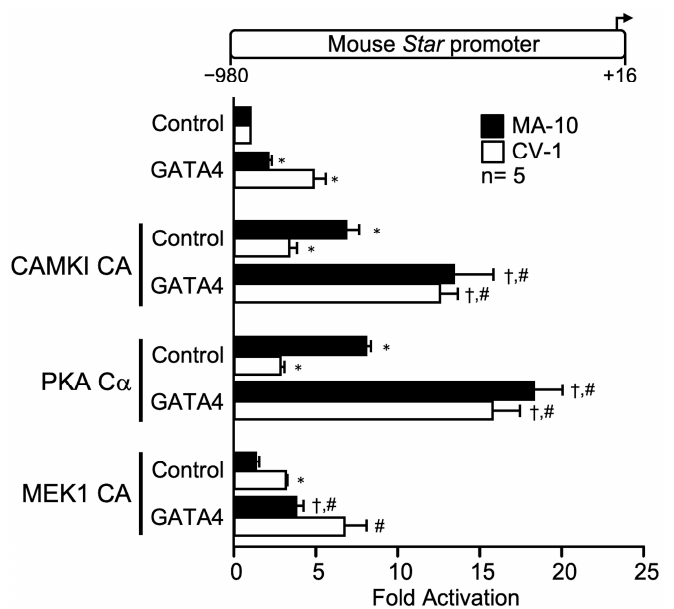
Figure 4. The zinc finger transcription factor GATA4 cooperates with CAMKI constitutively active (CAMKI CA), PKA catalytic subunit alpha (PKA C α ), and MEK1 constitutively active (MEK1 CA activates ERK1/2) on the mouse Star promoter. MA-10 Leydig (black bars) and CV-1 fibroblast (white bars) cells were cotransfected with a control empty expression vector or expression vectors for GATA4 and the different kinases (CAMKI CA, PKA C α , MEK1 CA) individually or in combination as indicated, along with a − 980 to +16 bp mouse Star reporter. Results are shown as Fold Activation over control ± SEM. An asterisk (*) represents a statistically significant difference in activation by the transcription factor or the kinase compared to control (empty expression vector, value set at 1, p < 0.05). A dagger (†) represents a statistically significant difference in activation between the transcription factor + the kinase compared to the corresponding transcription factor alone ( p < 0.05). A hashtag (#) represents a statistically significant difference in activation between the transcription factor + the kinase compared to the kinase alone ( p < 0.05). The number (n) of replicates is indicated.